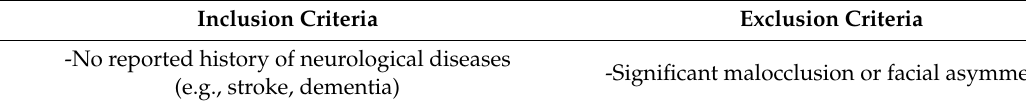
Table 1. Inclusion and exclusion criteria.